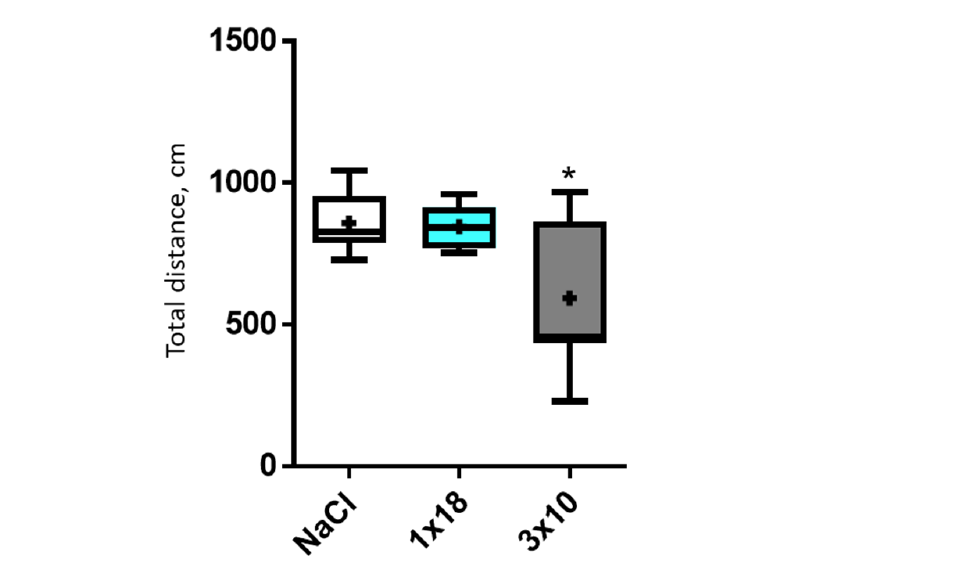
Figure 3. Changes in the dopamine (DA) concentration in the striatum ( A ) and changes in the do- pamine content in the substantia nigra ( B ) in mice 2 weeks after subcutaneous administration of 1- methyl-4-phenyl-1,2,3,6-tetrahydropyridine (MPTP): once at a single dose of 18 mg/kg (1 × 18) or three times at a single dose of 10 mg/kg with a 2-h interval between injections (3 × 10), compared to the controls (saline), taken as 100%. * p < 0.05, significant difference compared to the controls, taken as 100%; # p < 0.05, differences between the groups 1 × 18 and 3 × 10.